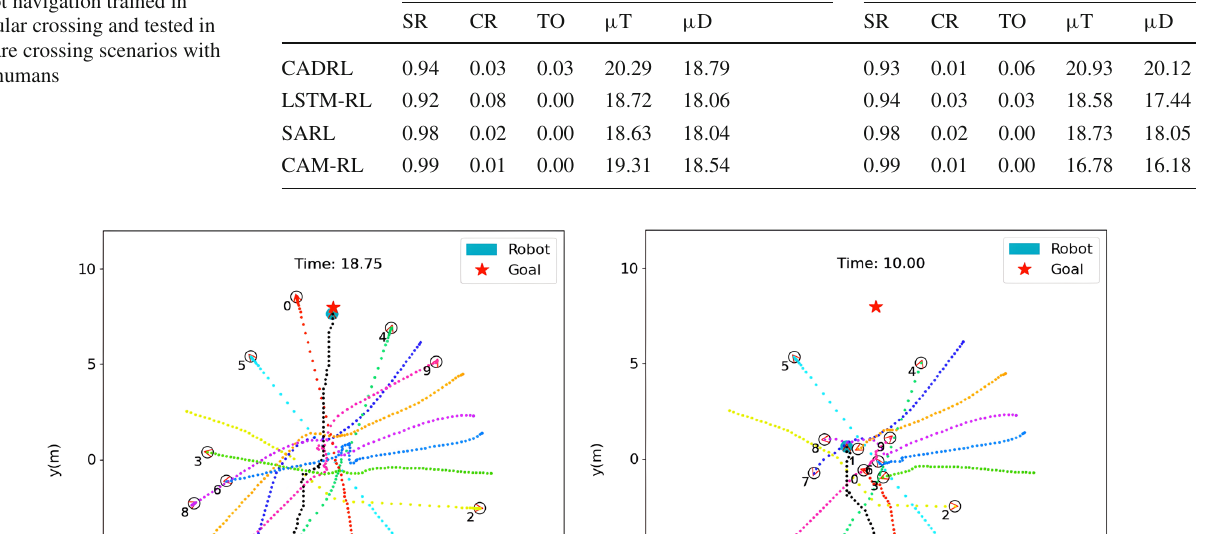
SARL has performed better than CADRL and LSTM-RL because of its collective importance to the crowd. The test results of SARL trained in a circular crossing scenario have yielded a success rate of 0 . 98 with a 0 . 02 collision rate. It has also operated well with the trained model in various testing